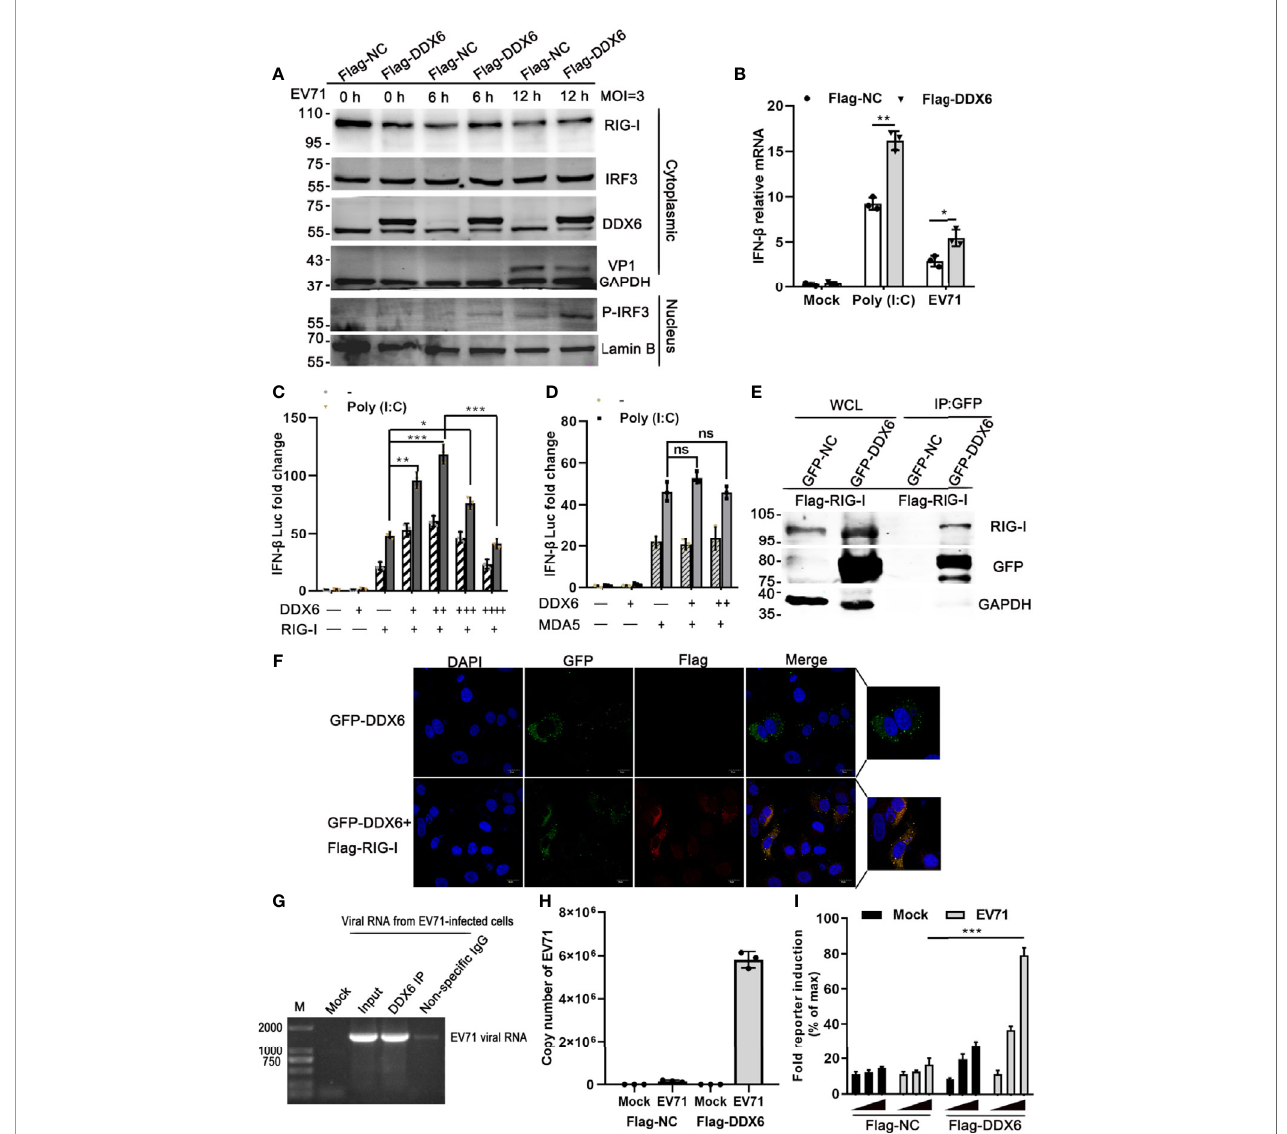
FIGURE 5 | DDX6 positively regulates RIG-I and promotes the activation of type-I IFN during EV71 infection. (A) HeLa cells were transiently transfected with a plasmid expressing DDX6 or control plasmid (pcDNA3.1- fl ag). After 24 h transfection, the cells were infected with EV71 at (MOI = 3) for 6 h and 12 h, respectively. The nucleus and cytoplasm extracts were determined by western blot using antibodies speci fi c for DDX6, VP1, RIG-I, MAVS, IRF3, P-IRF3, Lamin B, and GAPDH were used as the control for nucleus and cytoplasm, respectively. (B) The relative mRNA of IFN- b in HEK-293T was cotransfected with the plasmid vector or Flag- DDX6 and IFN- b for 24 h and stimulated by poly (I: C) or EV71 for 12 h, respectively. Data from three independent experiments were averaged. (C) Vectors expressing RIG-I, DDX6 were transfected into HEK-293T cells together with p125Luc (the IFN- b -luciferase reporter plasmid). After 24 h, the cells were unstimulated or stimulated with poly (I: C) for 12 h. Cell lysates were prepared, and luciferase activity was measured. +/++/+++ represents an increasing quantity of plasmid. (D) Vectors expressing MDA5, DDX6 were transfected into HEK-293T cells together with the IFN- b -luciferase reporter plasmid. After 24 h, the cells were left unstimulated or stimulated with poly (I: C) for 12 h. Cell lysates were collected, and luciferase activity was measured. (E) HEK-293T cells were transfected with Flag- RIG-I for 24 h, followed by transfection with plasmids encoding DDX6 or vector. Co-IP and immunoblotting were performed with the indicated antibodies. (F)